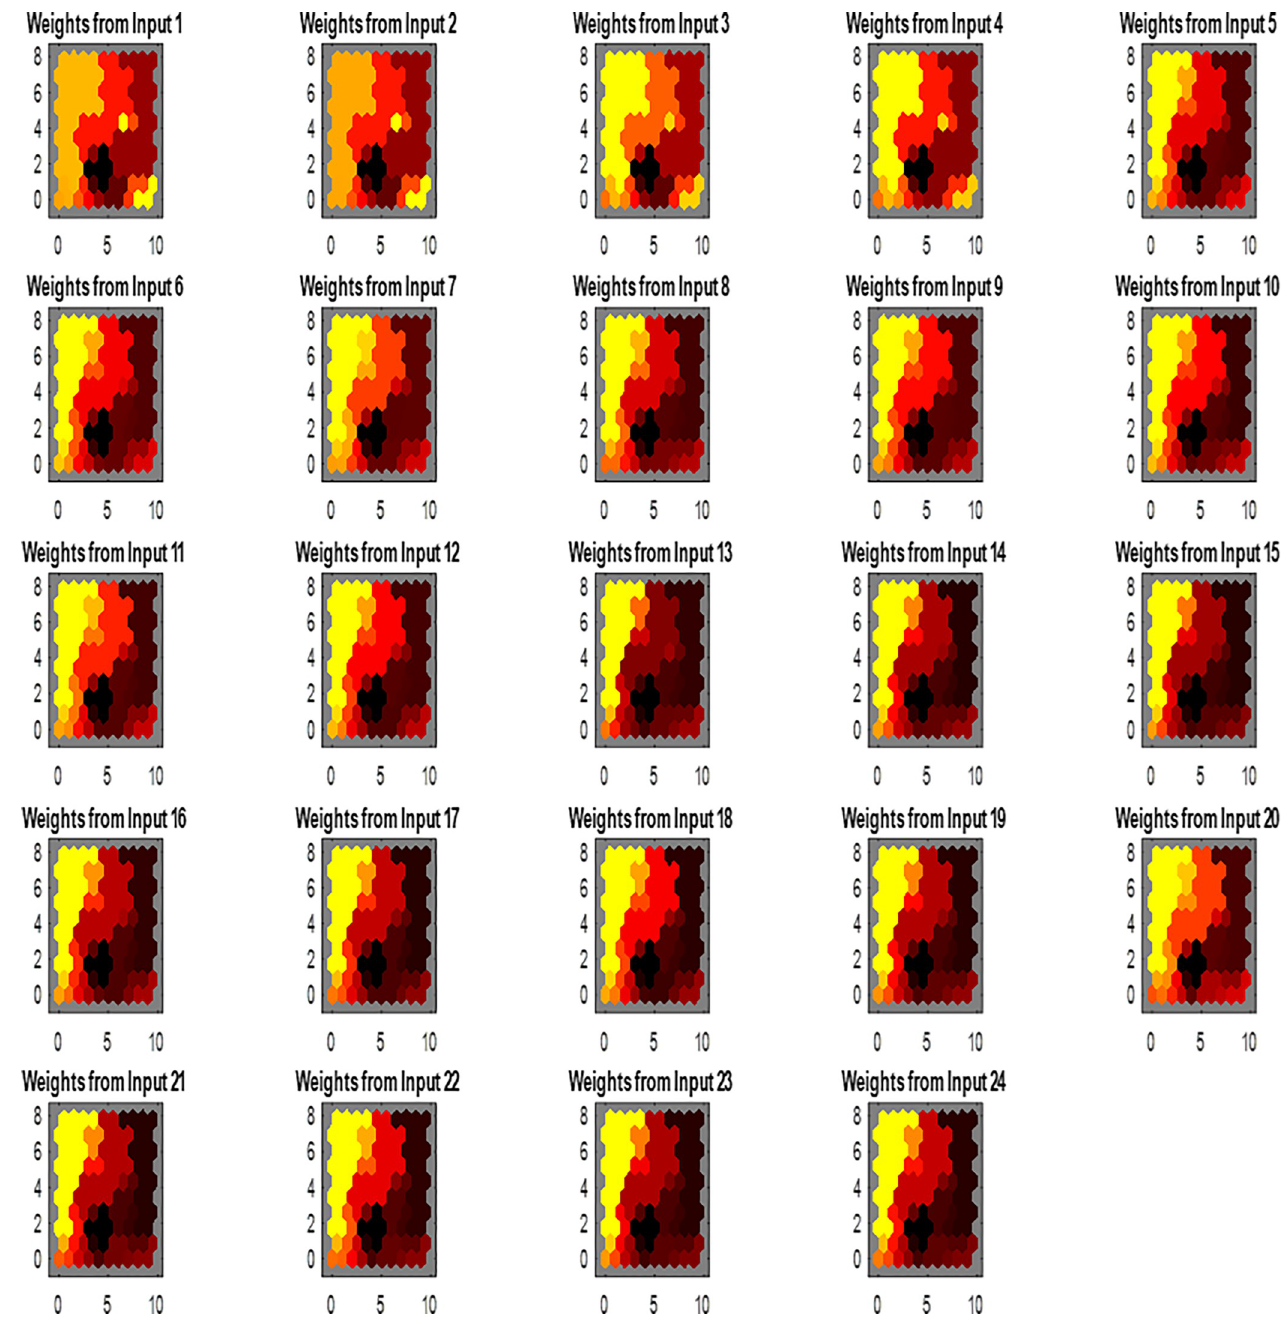
Fig 11. Schematic representation of weights (weight-1 and weight-2) assigned to the inter-connections for inputs used for the simulation of wheat grain yield using ten different input layers viz. grain N uptake, straw N uptake, grain K uptake, straw K uptake, total N uptake, total K uptake, SPAD value, green seeker value, RIUE N and RIUE K